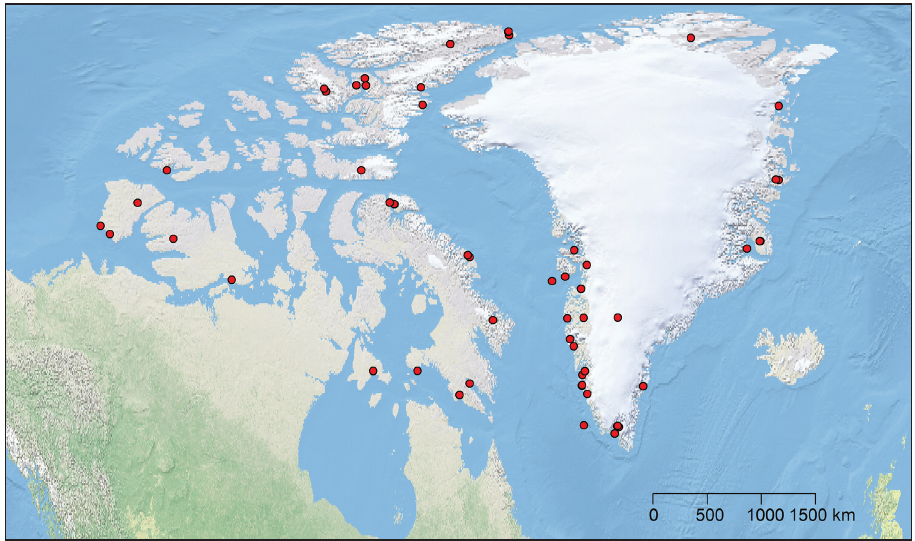
Figure 1. Greenland and Canadian Arctic Archipelago localities included in the present